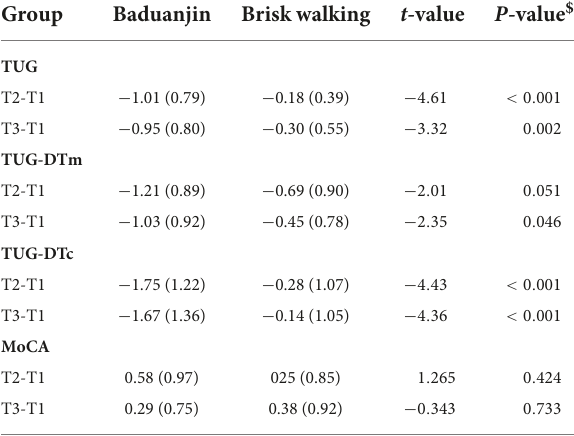
TABLE 4 Post-hoc analysis of the between-group